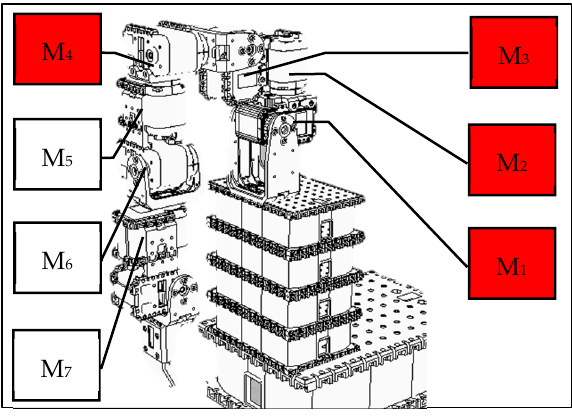
Figure 3. A humanoid robotic arm using V-REP simulation environment.